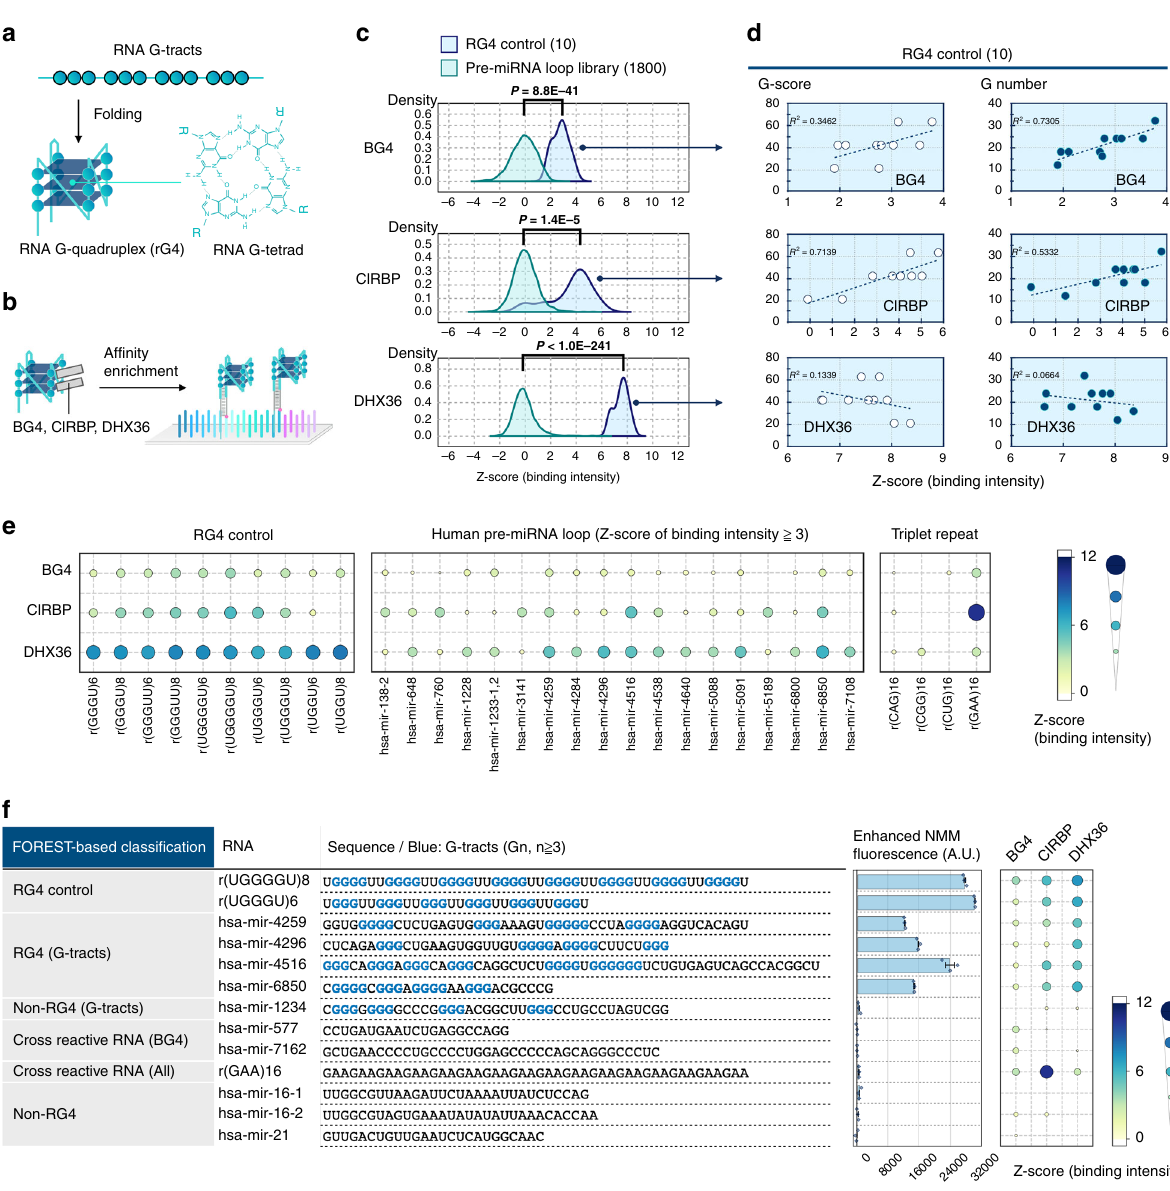
Fig. 5 The binding properties of RNA G-quadruplex-binding proteins revealed by FOREST. a Schematic of an rG4 structure. A canonical rG4 is formed by four repeats of sequential guanine nucleotides. A monolayer of rG4 is called a “ G-tetrad ” and consists of Hoogsteen base pairing. b Schematic of the FOREST-based characterization of rG4-binding proteins (BG4, CIRBP, and DHX36). c Average BG4-binding intensities comparing rG4 controls and human pre-miRNAs. The error bars indicate means ± s.d.; the p value was determined by the two-tailed Brunner – Munzel test. The data were calculated from the average of two independent experiments. d Scatter plots show correlations between the number of guanine nucleotides or G-scores for the binding intensity of rG4 controls (ten species). e The binding intensities of representative RNA structures; rG4 controls, triplet repeats, and pre-miRNA loops with Z -scores ≧ 3 for at least one protein. The size and color of a dot represent the Z -score of the binding intensity. f In vitro rG4-sensing assays validated rG4. Blue characters highlight rG4-forming sequences. rG4 formation was analyzed by using N-methyl mesoporphyrin IX (NMM), which senses rG4 by enhanced fl uorescence ( λ ex = 399 and λ em = 610 nm). The error bars indicate means ± s.e.m.; the rG4-sensing assays were performed with three biological replicates, each with two technical replicates. Each “ ◇ ” indicates a data point. Source data are provided as a Source Data fi